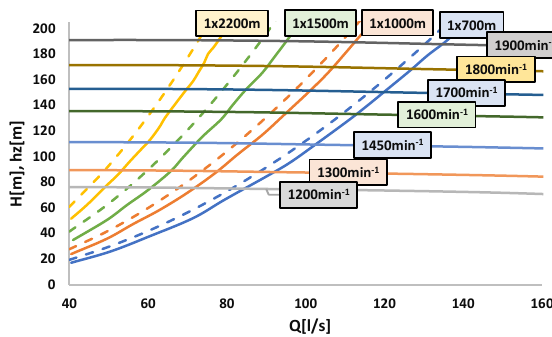
Fig. Pipeline characteristics for 1xDN150 - 700, 1000, 1500, 6. 2200 m (solid line – Methodology, dashed line – MATLAB) .